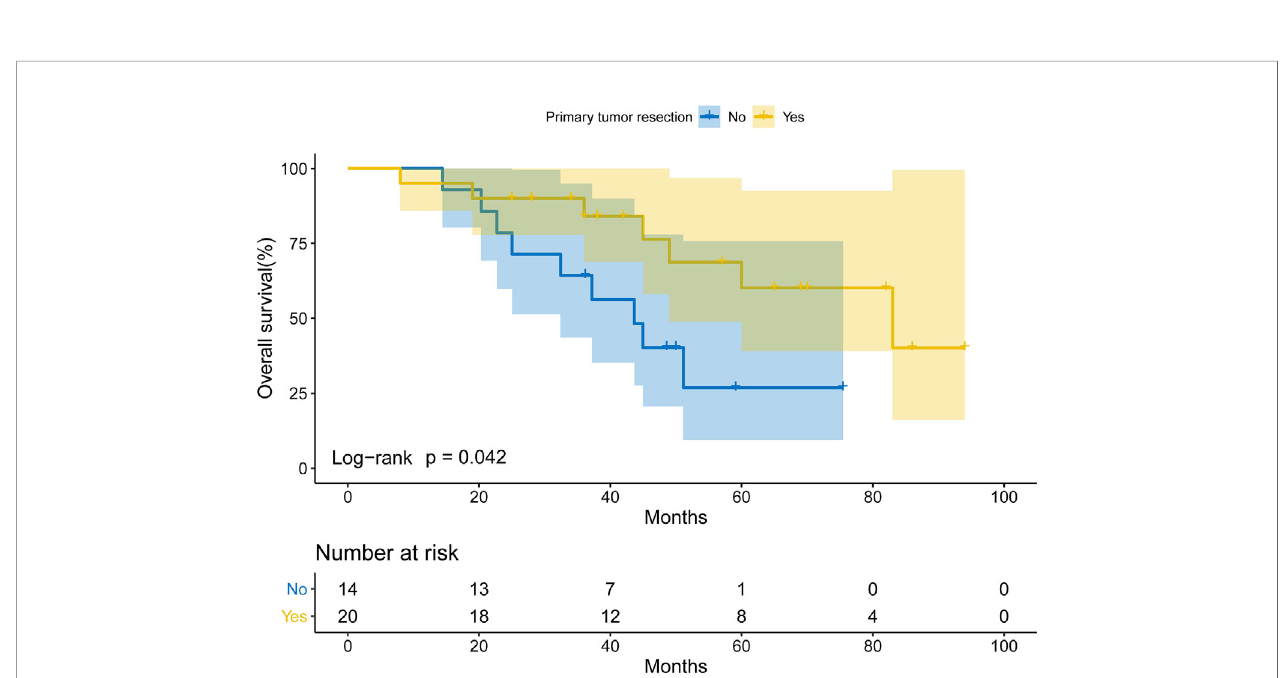
FIGURE 2 | Overall survival of EGFR-TKIs-treated patients with intraoperatively-con fi rmed M1a lung adenocarcinoma receiving or not receiving primary tumor